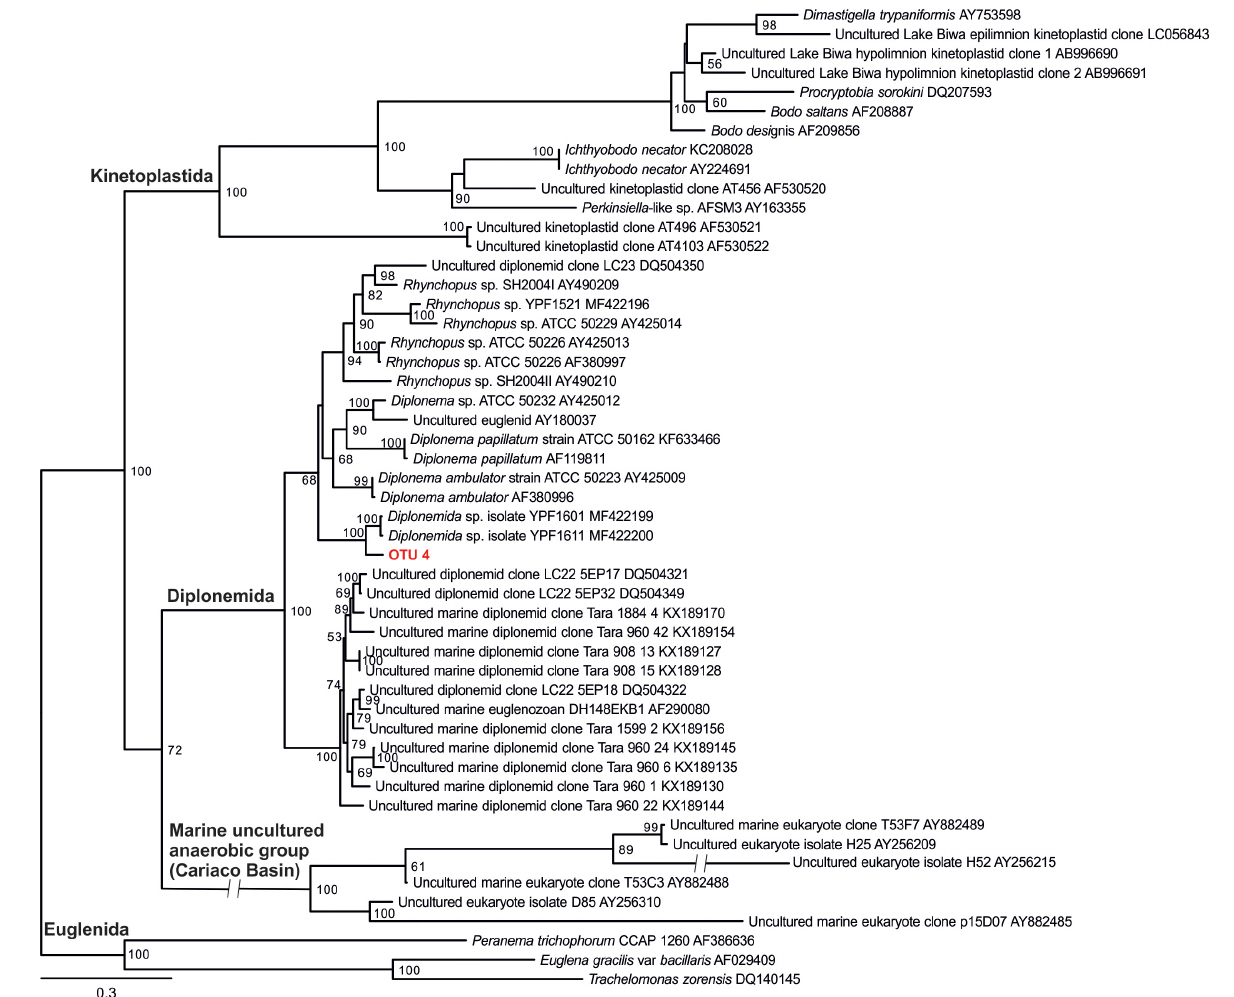
FIGURE 6 | 18s rRNA gene phylogenetic tree of diplonemid from freshwater deep lakes of Japan with 28 sequences of cultured and environmental sequences of marine diplonemids. The diplonemid OTU obtained from the present study (OTU 4) is highlighted in bold and red color. Kinetoplastids and other euglenozoan sequences were considered as outgroup. ML tree was inferred with standard bootstraps (-b 100). Scale bar = 0.3 substitution per site.